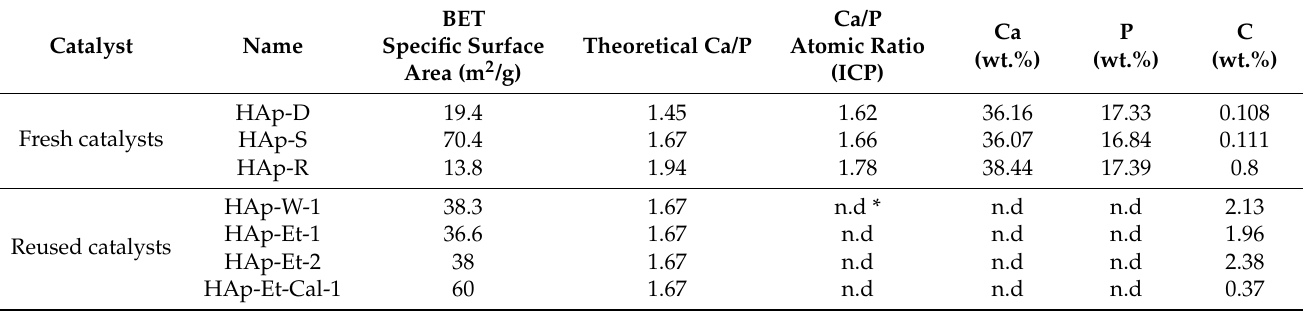
Table 2. Chemical compositions and surface areas of fresh and reused